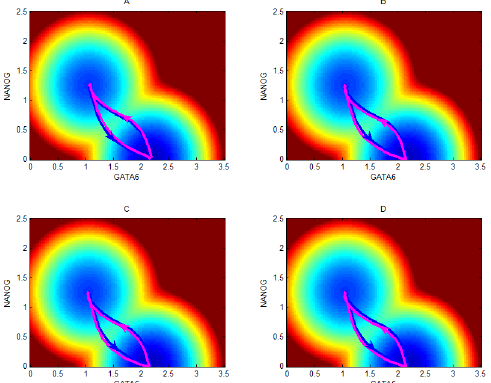
Figure 7. Global sensitivity for kinetic paths. The developmental and reprogramming paths comparisons before and after mutations are shown separately for mutation 1 (increase link R1, i.e. the repression of CDX2 to OCT4)(A), mutation 2(increase link R2, i.e. the repression of OCT4 to GATA6)(B), mutation 3 (increase link R3, i.e. the repression of NANOG to GATA6)(C), and mutation 4 (increase link R4, i.e. the repression of GATA4 to GATA6)(D). The blue paths represent kinetic paths before mutations, and the magenta paths represent the kinetic paths after mutations. The blue arrows represent differentiation direction (from left stem cell attractor to the right differentiation attractor), and the magenta arrows represent reprogramming direction (from right attractor to left attractor). The diffusion coefficient D ~ 0 : 01 .